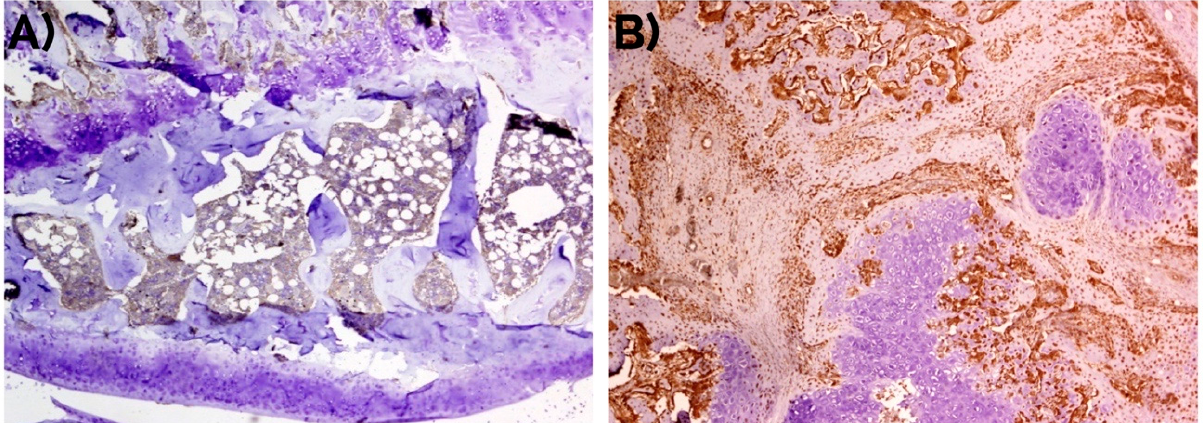
Figure 3. Negative detection of musashi-1 at day 14 in ( A ) unfractured controls in comparison with ( B ) bone fracture callus, as also represented in Figure 1. Peroxidase-conjugated micropolymer detection. Original magnification: 10×. An intense nuclear expression of MSI1 was observed in fusiform mesenchymal cells and immature chondrocytes in the fibrocartilage. In osteoblasts, MSI1 was detected in the nucleus and the cytoplasm. MSI1 was not detected in mature hypertrophic chondrocytes (Figure 4).